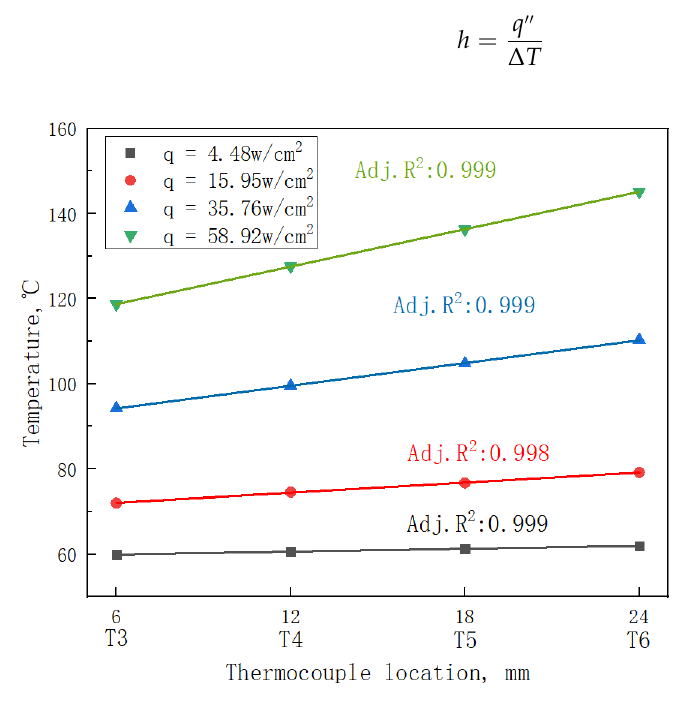
Figure 6. Heat flux regression curves of the device.